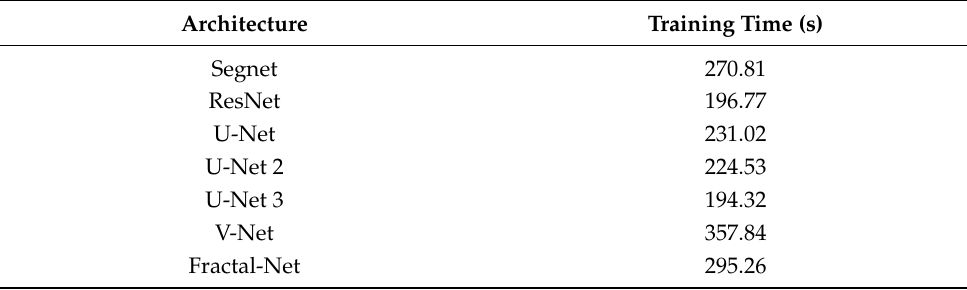
Table 7. Performance Training